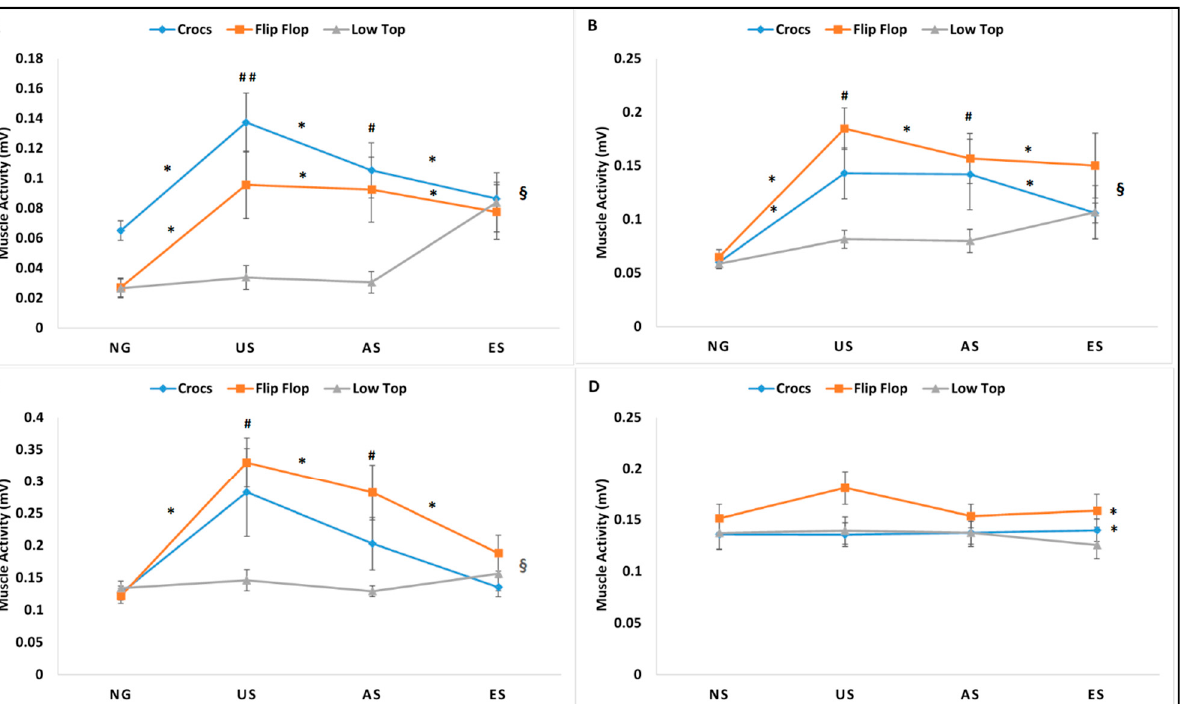
Figure 5. Peak muscle activity (mV) for vastus medialis ( A ), medial hamstrings ( B ), tibialis anterior ( C ), and medial gas- trocnemius ( D ) during stance phase for Crocs, flip-flops, and low top slip resistant shoe during normal gait (NG), unex- pected slip (US), alert slip (AS), and expected slip (ES) events. § denotes significant interaction between footwear type and